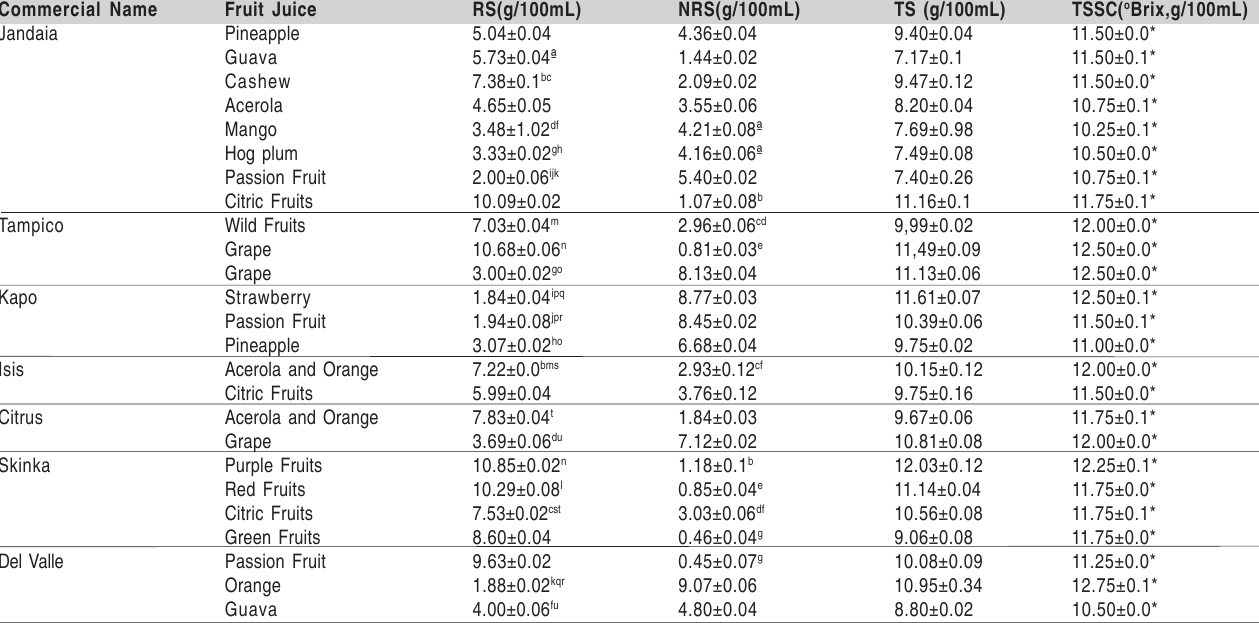
Table 3. Distribution of the fruit juices according to the mean values for reducing sugars (RS), non-reducing sugars (NRS), total sugars (TS) and